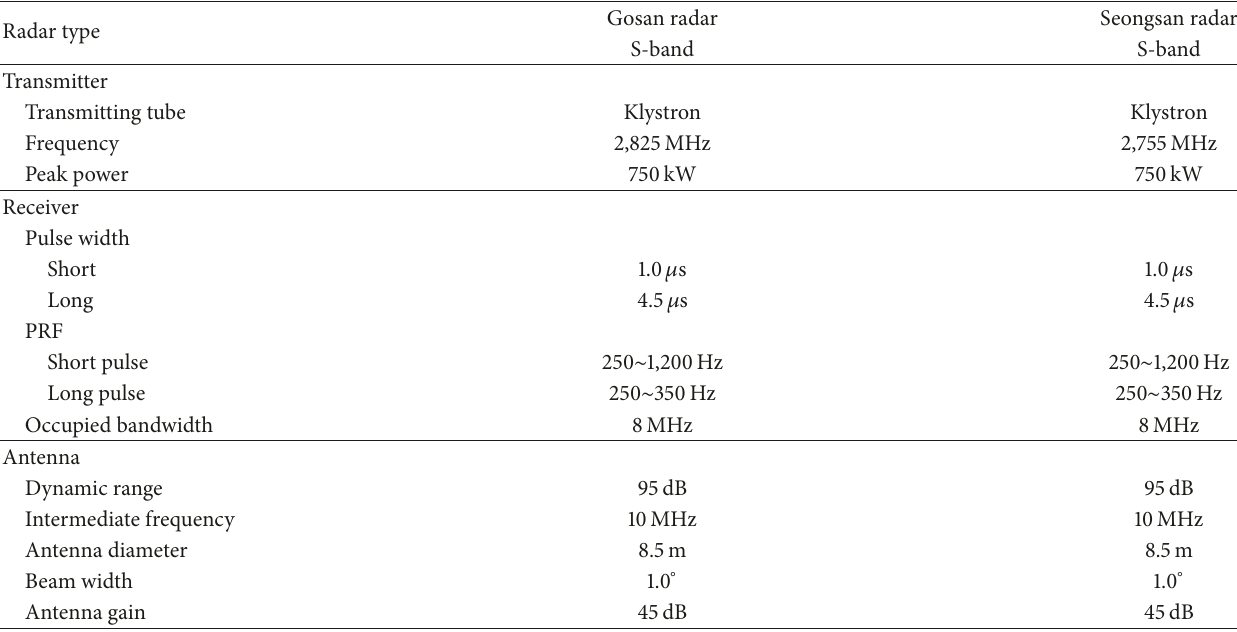
Table 1: Major specification of the Gosan and Seongsan